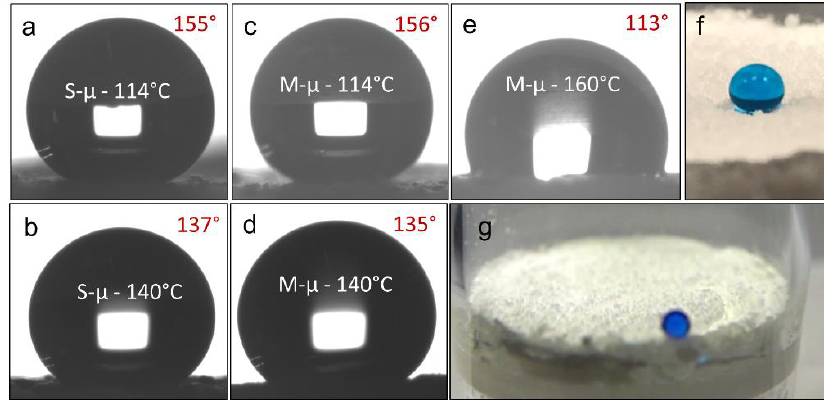
Figure 5. ( a – e ) Images showing WCAs for the PE secondary layer sprayed on a glass slide. The powder sizes and heat-treatment temperatures are: S-µ powder heated at ( a ) 114 °C, ( b ) 140 °C, and M-µ powder heated at ( c ) 114 °C, ( d ) 140 °C and ( e ) 160 °C. ( f ) A 20-µL water droplet on an S-filter mounted in a glass funnel where the PE dual-layer filter is placed. Besides light distortion through glass, some polymer features are covering the liquid/air interface at the filter surface, making accurate measurements of CAs challenging. ( g ) An image from bouncing experiment on a PE filter.